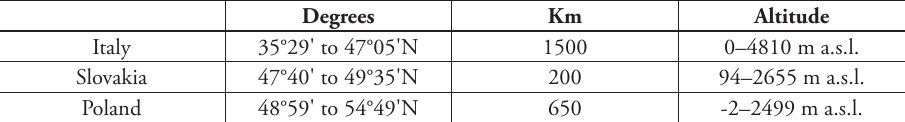
table 1. Range of latitudes (in degrees and in km) and altitudes for the considered